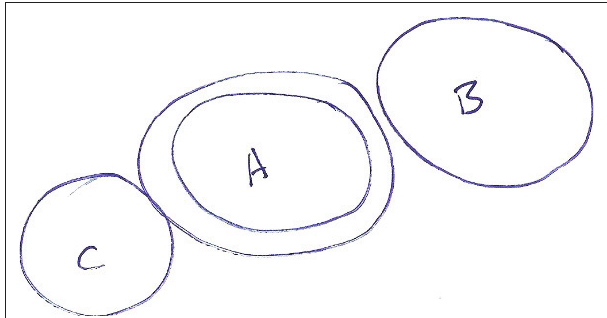
FIGURE 1: Learner A’s mathematical model for the three